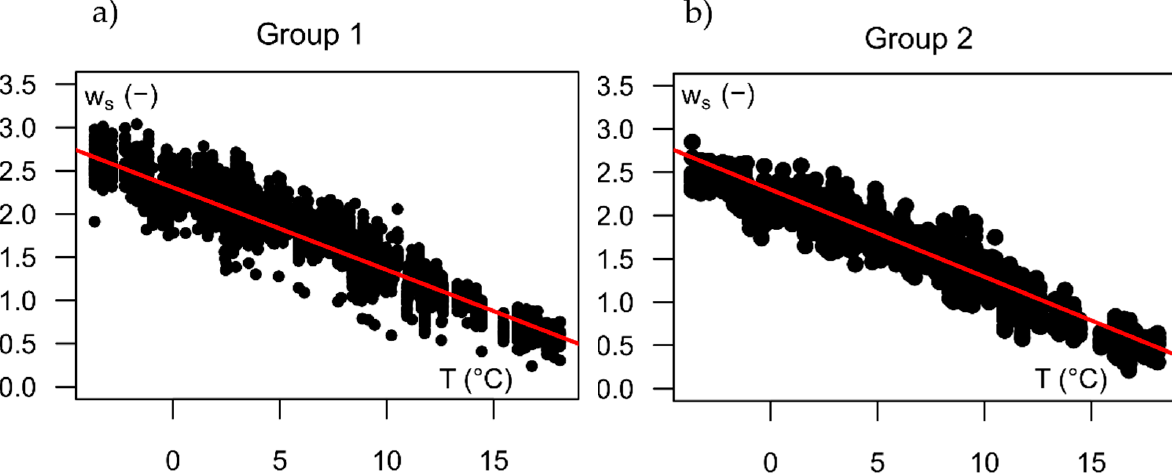
Figure 7. Seasonal heat load pattern during the period of the heating season versus outside temperature ( ◦ C) and linear regression trend (red line); group 1 in ( a ), and group 2 in ( b ).